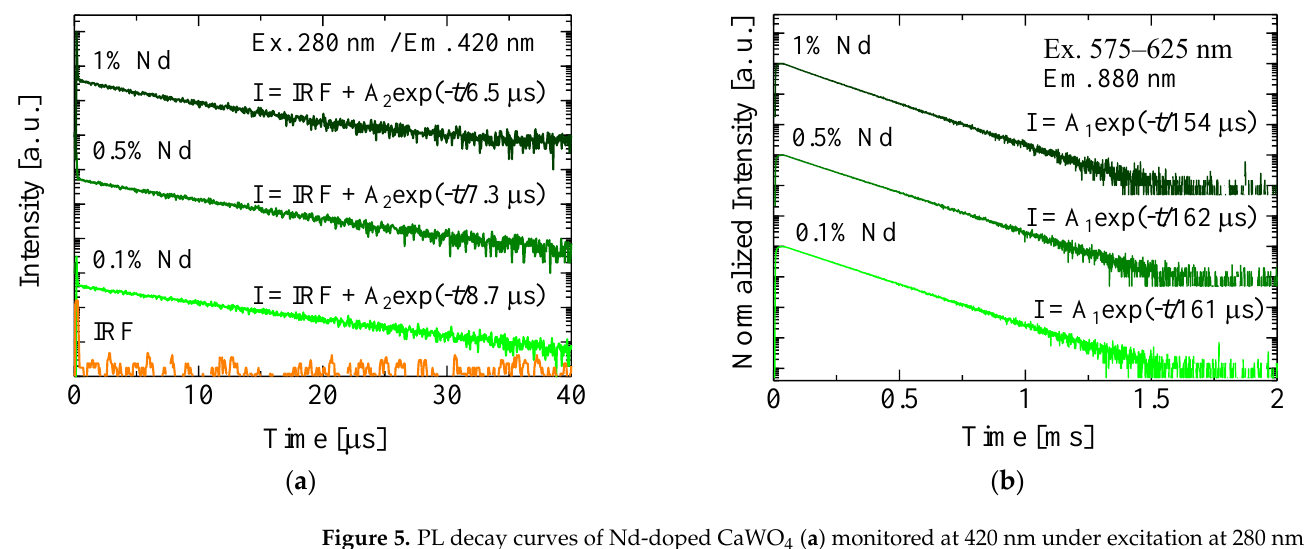
Figure 5. PL decay curves of Nd-doped CaWO 4 ( a ) monitored at 420 nm under excitation at 280 nm and ( b ) monitored at 880 nm under excitation at 575 – 625 nm. Figure 6a,b show the X-ray-induced scintillation spectra of the crystals when monitored at 300–600 nm and 700–1500 nm, respectively. A broad emission with the peak top at 420 nm was observed at 300–600 nm. The emission is composed of double peaks derived from the charge transfer transition in (WO 4 ) 2 − anion complex and some defects such as oxygen and lattice defects [39]. In the NIR range, some sharp emission lines were confirmed at 900, 1060, and 1300 nm. Almost the same spectral features due to Nd 3+ were observed in other materials doped with Nd [40–42]; hence the emissions would originate from the Nd 3+ .